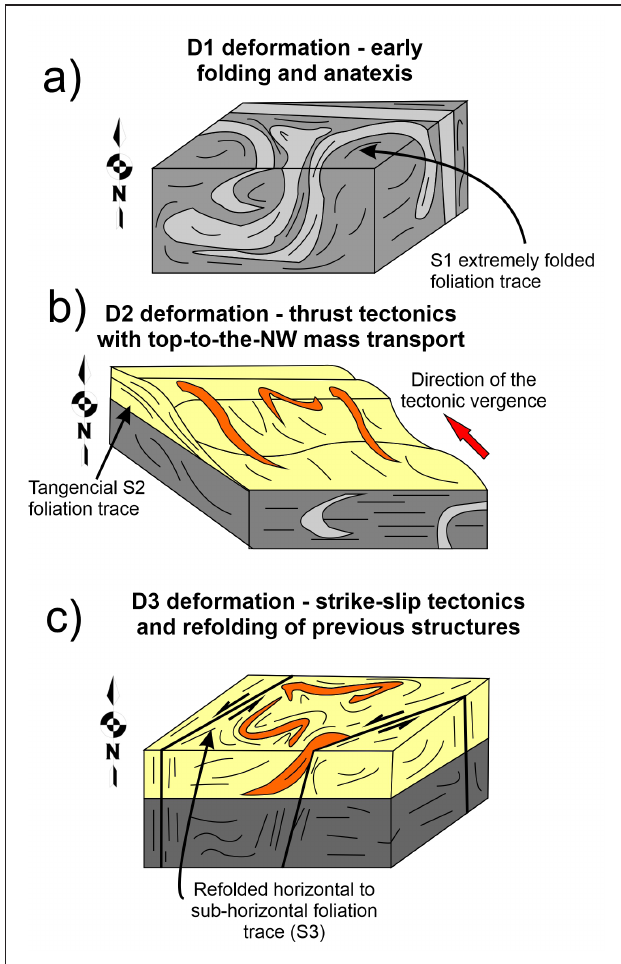
FIGURE 4 Proposed schematic evolution of the studied area: (a) Anatexis and the development of early folding and neosome of the basement rocks; (b) Nappe-like development structure with top-to- the-NW tectonic mass transport; (c) folding and refolding of previous structural markers, mostly due to nucleation of the Sinistral Xinxó and Congo-Cruzeiro do Nordeste shear zones. low-dipping sheets of orthogneisses, whose major kinematic markers suggest top-to-the NW tectonic vergence, coinciding with a number of thrust-related structures within the Alto Moxotó Terrane described as the Riachão do